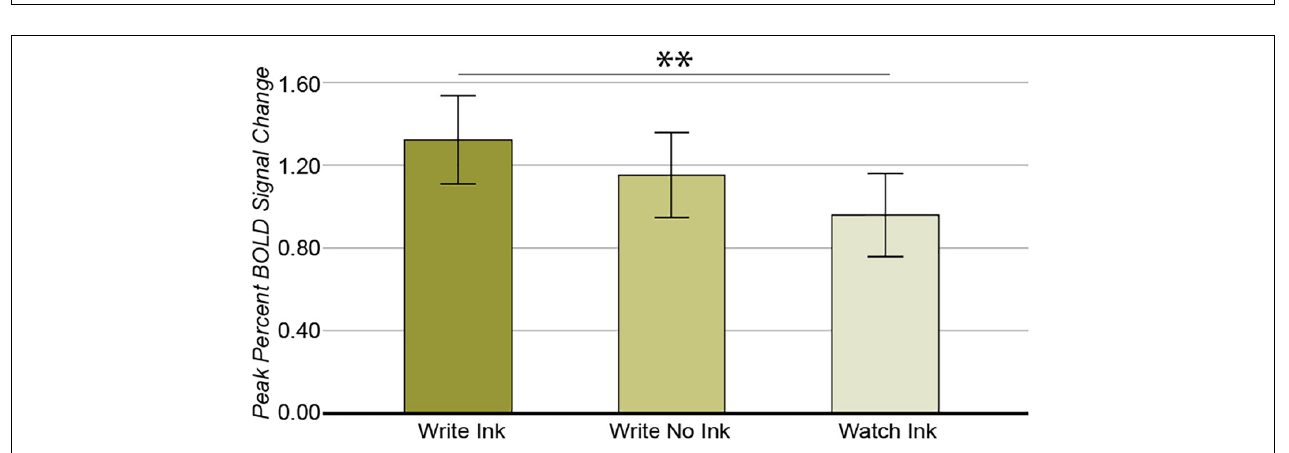
FIGURE 6 | Left middle intraparietal sulcus. (A) Main effect of AGE GROUP. (B) Main effect of CONDITION. (C) Interaction between AGE GROUP and CONDITION. Error bars represent 95% confidence intervals. ∗∗∗ p < 0.001; ∗∗ p < 0.01; ∗ p < 0.05.